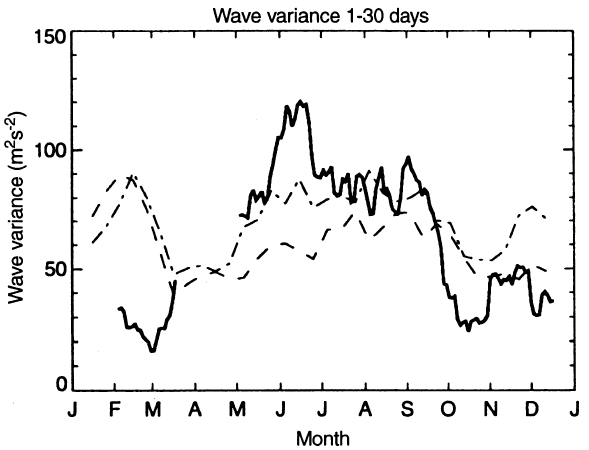
Fig. 4. The total variance (m 2 s (cid:255) 2 ) is shown computed from the South Pole observations during 1995 ( solid ) for waves with periods between 1 and 30 days. The variance is computed for every other day throughout the year utilizing 30 days of daily averaged data. Also shown are the meridional ( dashed ) and zonal ( dash-dot ) estimated wave variances computed using meteor data from Molodezhnaya (68 (cid:14) S) for 1986